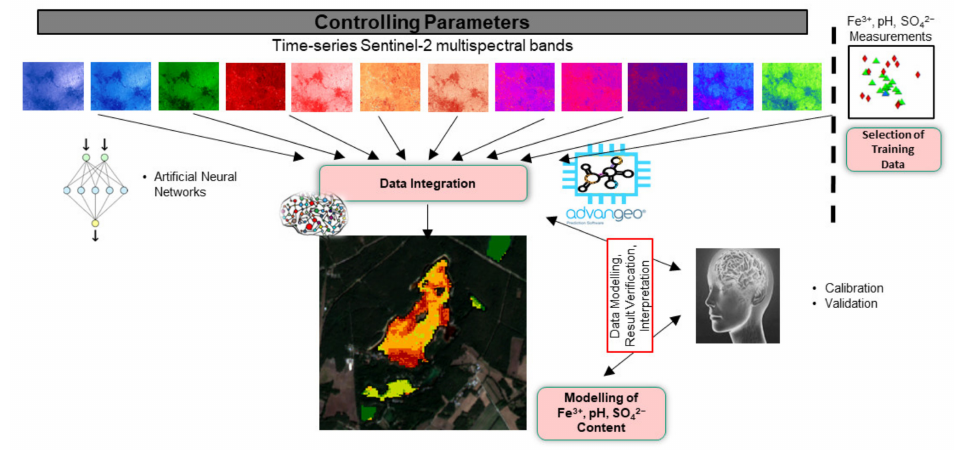
Figure 13. General processing schema of the prediction modelling using artificial neural